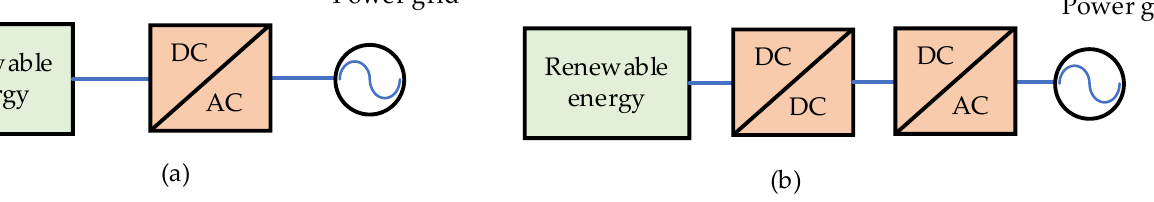
Figure 8. Power conversion stage of VSG ( a ) Single-stage structure; ( b ) dual stage structure.